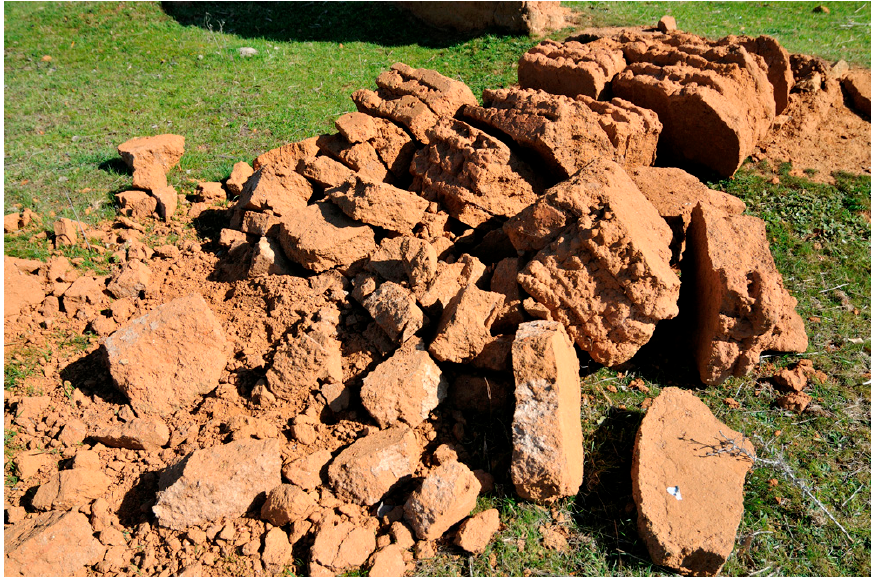
Figure 2. The collapsed southeastern block as seen from the southeast on 30 September 2015. Note the clean breaks and lack of bonding between the compaction layers. Reprinted from Ref. [9] .